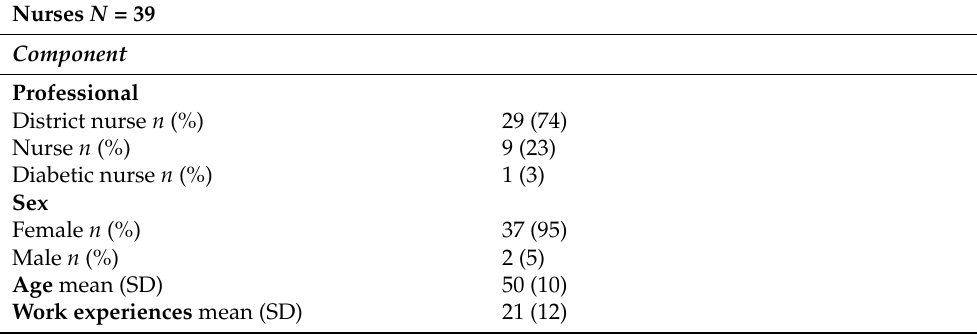
Table 1. The nurses’ demographic data.